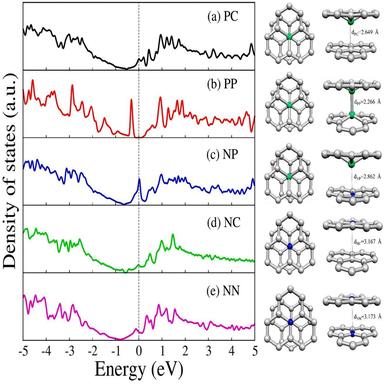
Electronic density of states of substitutional phosphorus- and nitrogen-doped double-layer graphene with AB stacking. The vertical dashed line indicates the Fermi level. The ball-stick models of the optimized structures are shown (right side), and the zone around dopants is also shown for better visualization. (a) Single phosphorus atom doping a graphene layer (labeled as PC). (b) Two phosphorus atoms doping both graphene layers (labeled as PP). (c) Phosphorus-nitrogen doping (labeled as PN), (d) single-nit